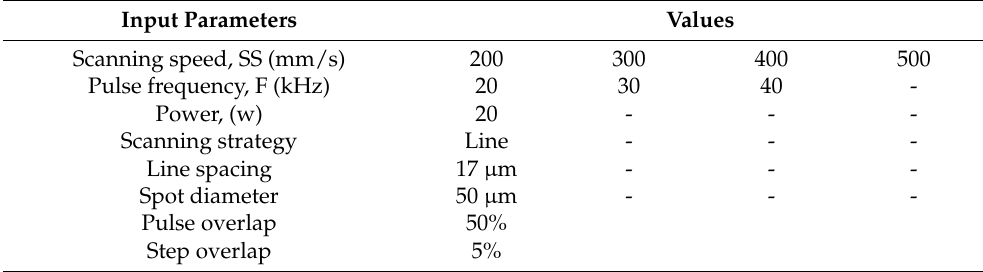
Figure 3. ( a ) Laser beam machining setup; ( b ) schematic diagram of laser beam machining. Microchannels with the dimensions of 250 µ m in width and 5 mm in length were fabri- cated on all produced GNP/Al 2 O 3 nanocomposites with varying GNP contents. Before the main experiments, all fabricated samples were ground to remove the superficial graphite and oxide layers and non-uniformity. Later, two laser parameters, i.e., the scanning speed and pulse frequency, were varied during the laser micro-milling. There is no informa- tion available in the literature regarding the laser micromachining of GNP/Al 2 O 3 matrix nanocomposites. Therefore, initially, preliminary tests were conducted to identify the suitable ranges of influential factors using the reported studies on the micromachining of alumina ceramics [40,42,43]. Table 4 shows the selected laser parameters and their ranges. Table 4. Laser parameters and their selected